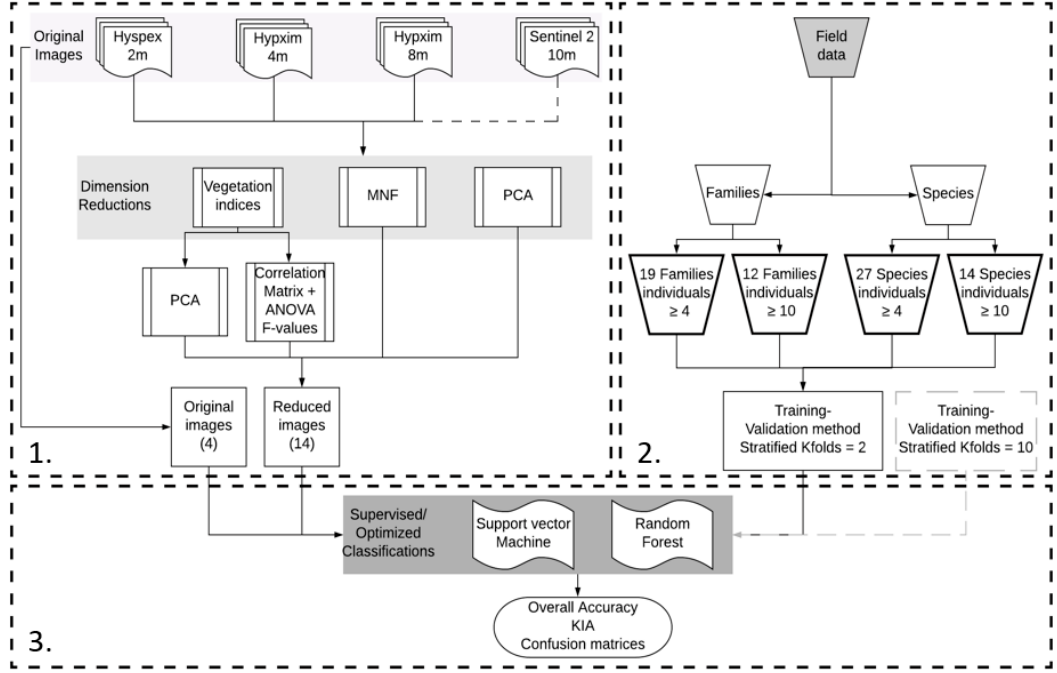
Figure 2. General methodological approach. Box 1 lists the tested Dimension Reduction methods providing 14 reduced hyperspectral datasets and compared with the 3 unreduced original ones and the simulated Sentinel2 data—MNF and PCA are also applied on Sentinel2 (cf. Section 2.4.2). Box 2 lists the training data and methods used to train and validate the classification (cf. Section 2.4.3). Box 3 represents the two classifiers and criteria used to evaluate classifications’ accuracy (cf. Section 2.4.4).